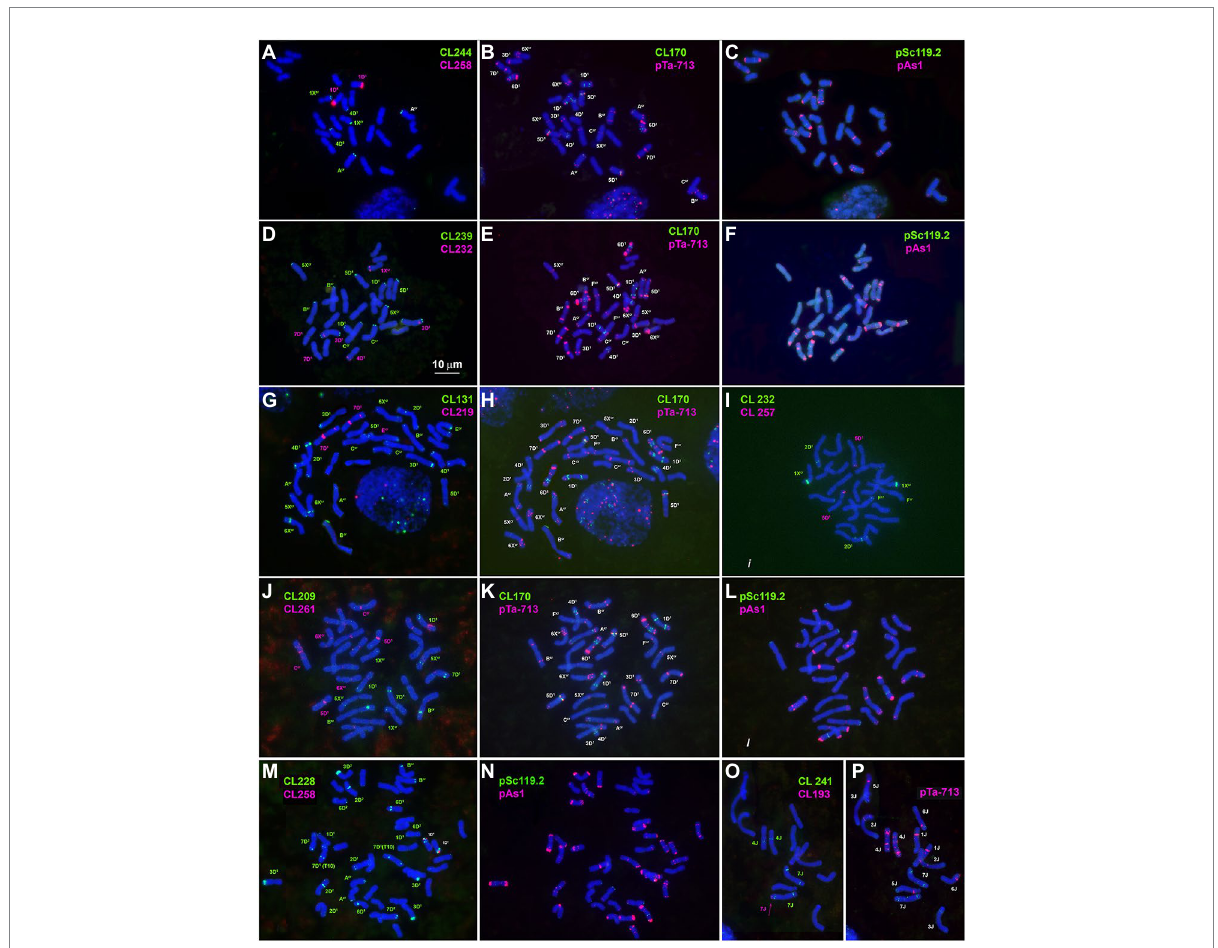
FIGURE 1 Metaphase cells of Ae . crassa , 4x (A–L) and 6x (M,N) , and of Th . bessarabicum (O,P) after FISH with different probe combinations; (A–C) the cell of 4x Ae . crassa AE 742 hybridized consecutively with CL244 + CL258 followed by CL170 + pTa-713 and pAs1 + pSc119.2; (D–F) - the cell of 4x Ae . crassa AE 742 hybridized consecutively with CL239 + CL232 followed by CL170 + pTa-713 and pAs1 + pSc119.2; (G,H) - the cell of 4x Ae . crassa AE 742 hybridized consecutively with CL131 + CL219 followed by CL170 + pTa-713; (I) - the cell of 4x Ae . crassa AE 742 hybridized with CL232 and CL257; (J–L) - the cell of 4x Ae . crassa AE 742 hybridized consecutively with CL209 + CL261 followed by CL170 + pTa-713 and pAs1 + pSc119.2; (M,N) – the cell of 6x Ae . crassa AE 131680 hybridized consecutively with CL228 + CL258 followed by pAs1 + pSc119.2; (O,P) – the cell of Th . bessarabicum PI 201890 hybridized with CL193 + CL241 followed by pTa-713. Probe combinations are given on the top of the respective images; probe color corresponds to signal